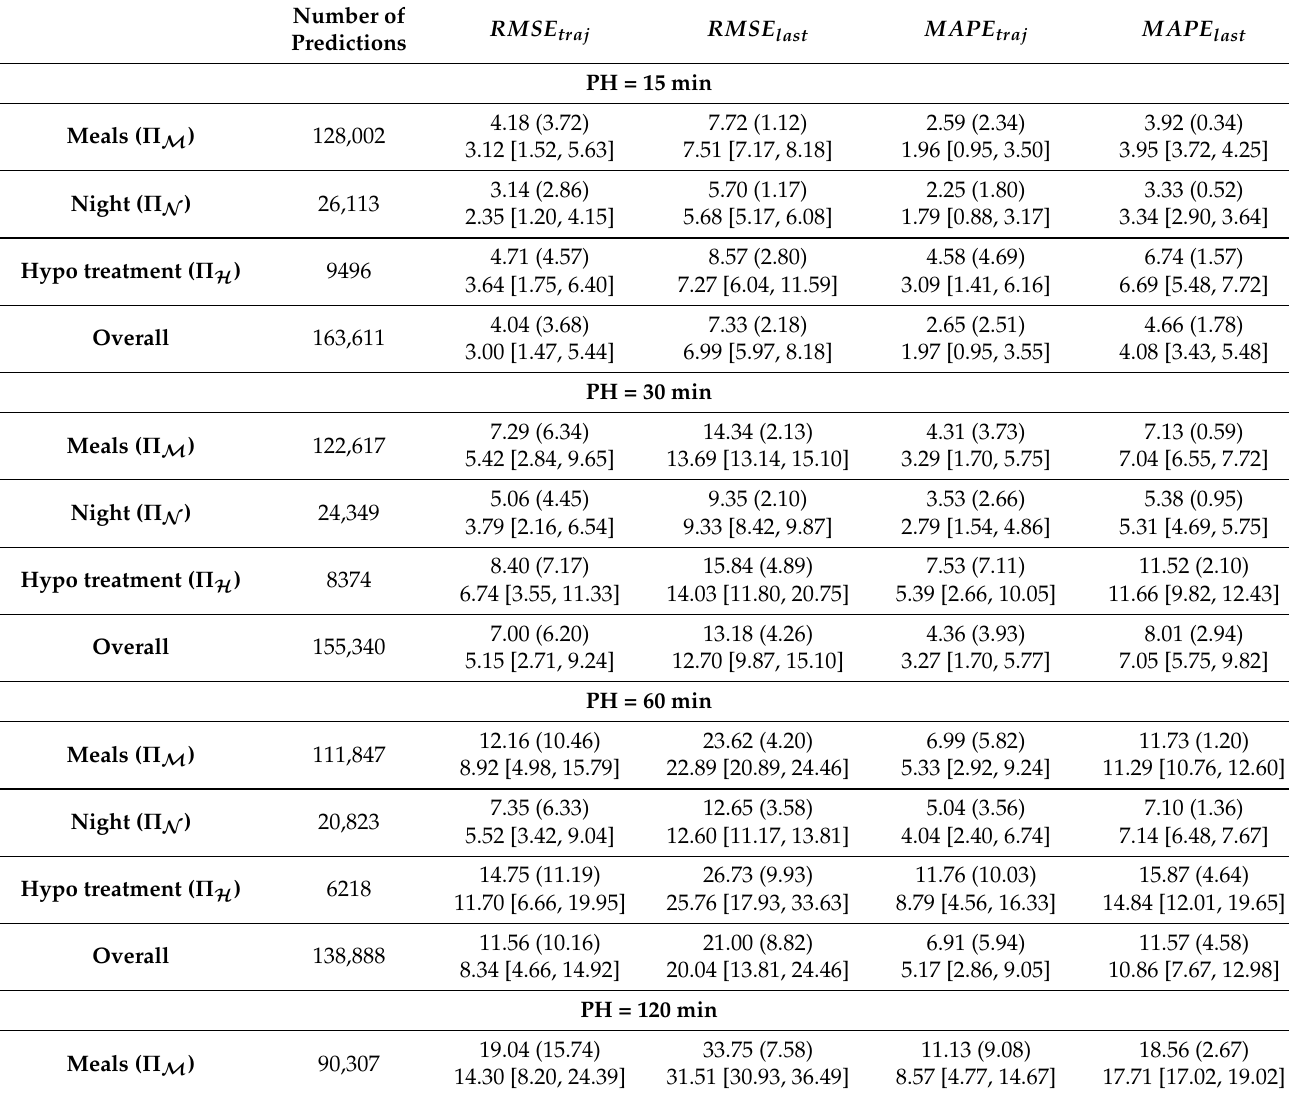
Table 6. Accuracy metrics of the glucose predictor for validation dataset 2